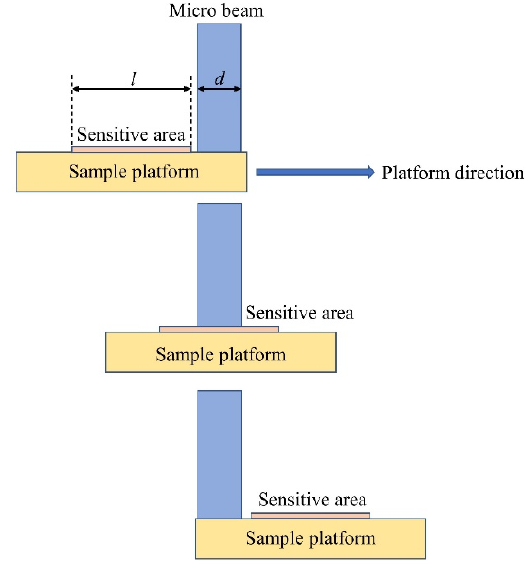
Figure 5. Schematic of SEU-sensitive-area positioning method.